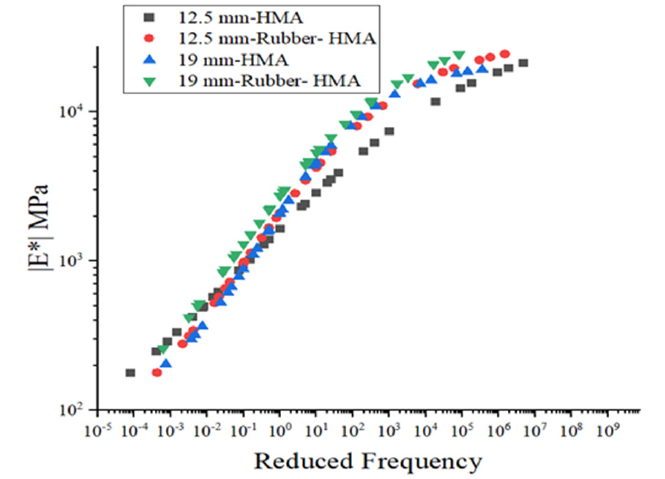
Figure 8. Dynamic modulus mastercurve of HMA (@ 21 °C).